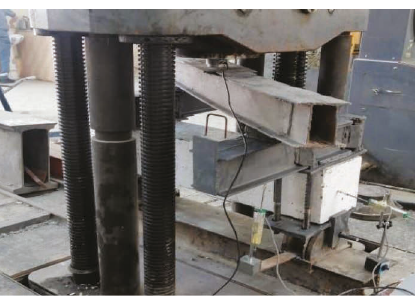
Figure 3: The torsional test